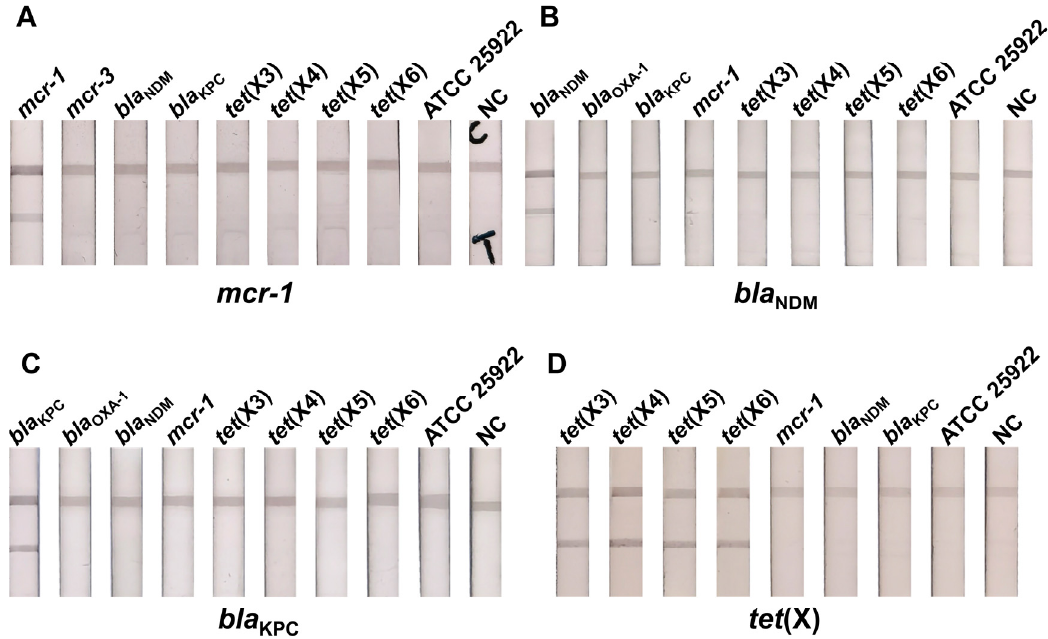
Figure 5. Speci fi city analysis for pan-drug-resistant genes testing in urine samples. ( A ) mcr-1 , ( B ) bla NDM , ( C ) bla KPC, ( D ) tet (X). NC, negative control. ( B ) bla NDM , ( C ) bla KPC, ( D ) tet (X). NC, negative